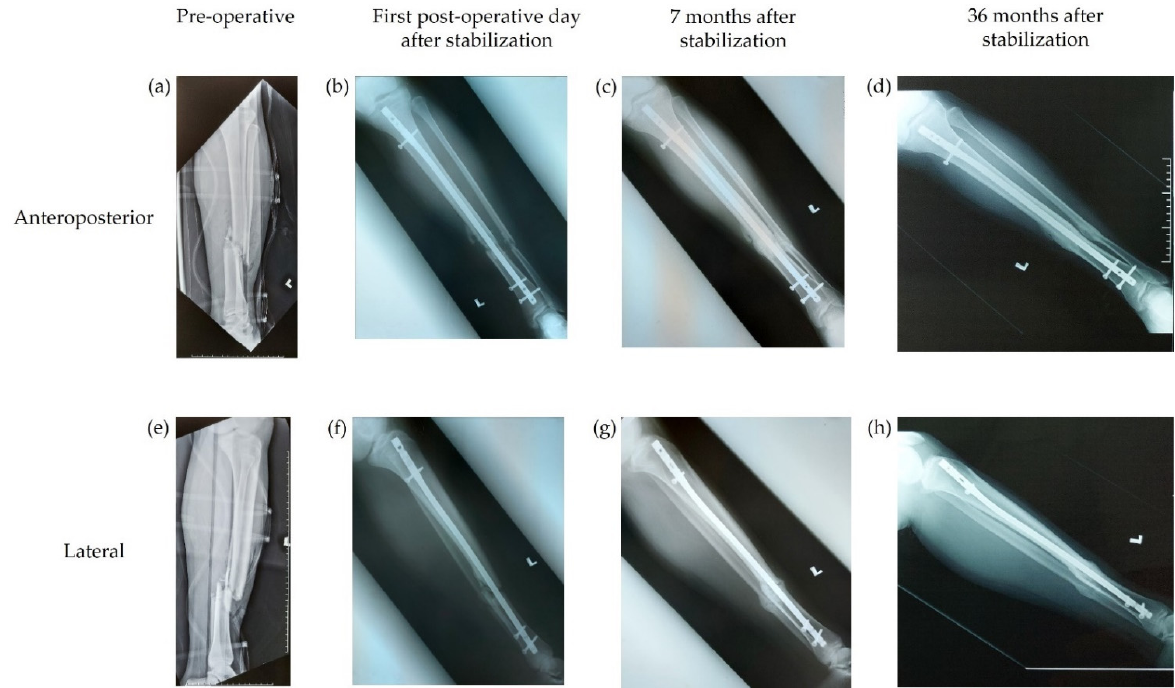
Figure 1. Example of timely bony union, as assessed by the independent experts. Radiographs from a 64-year-old male patient with a Gustilo type IIIa open tibial fracture. ( a – d ) Anteroposterior radiographs. ( e – h ) Lateral radiographs. ( a , e ) Radiographs taken pre-operatively; ( b , f ) radiographs taken on the first post-operative day after stabilization of the fracture; ( c , g ) radiographs taken 7 months after stabilization and demonstrate bony union; and ( d , h ) radiographs taken 36 months after stabilization.